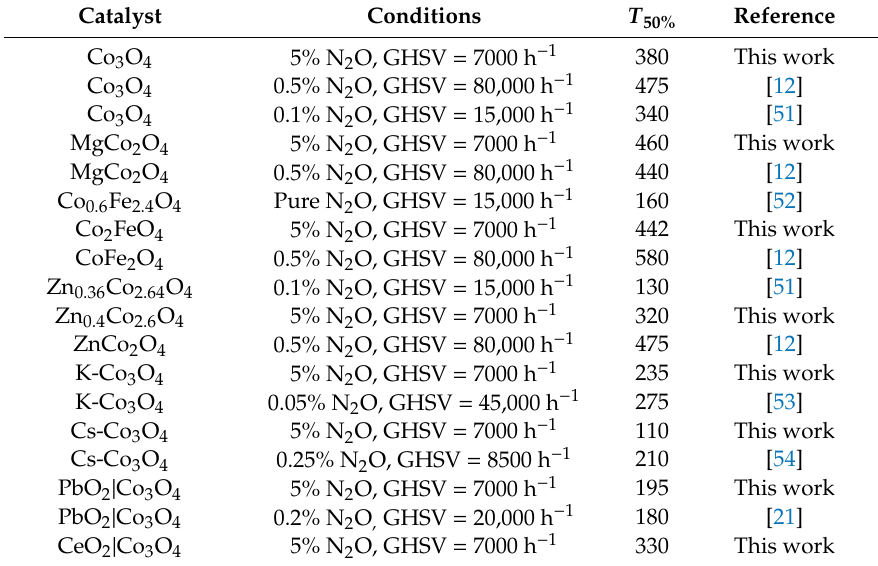
Table 2. Selected spinel-based catalysts deN 2 O performance in terms of the temperature of